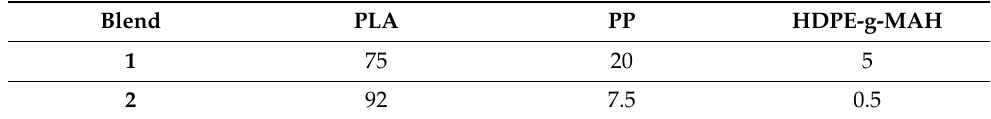
Table 2. Compositions of blends prepared in the single-screw extruder.